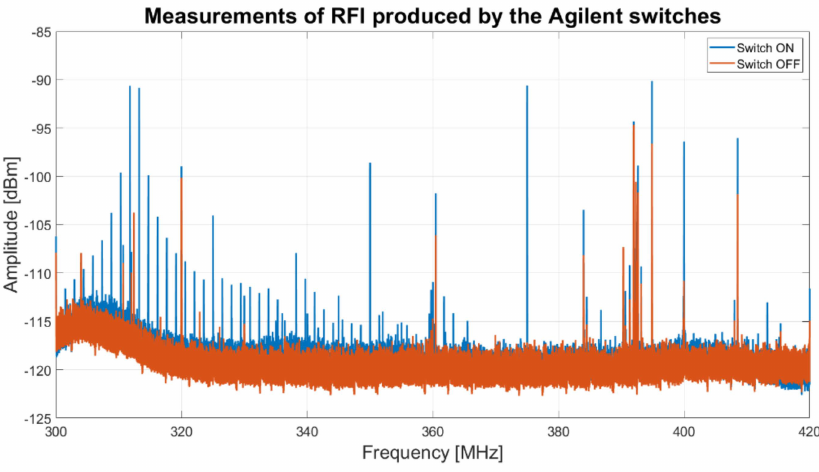
Figure 13. Results of the measurement campaign for surveying the signals generated by the Agilent 8761B